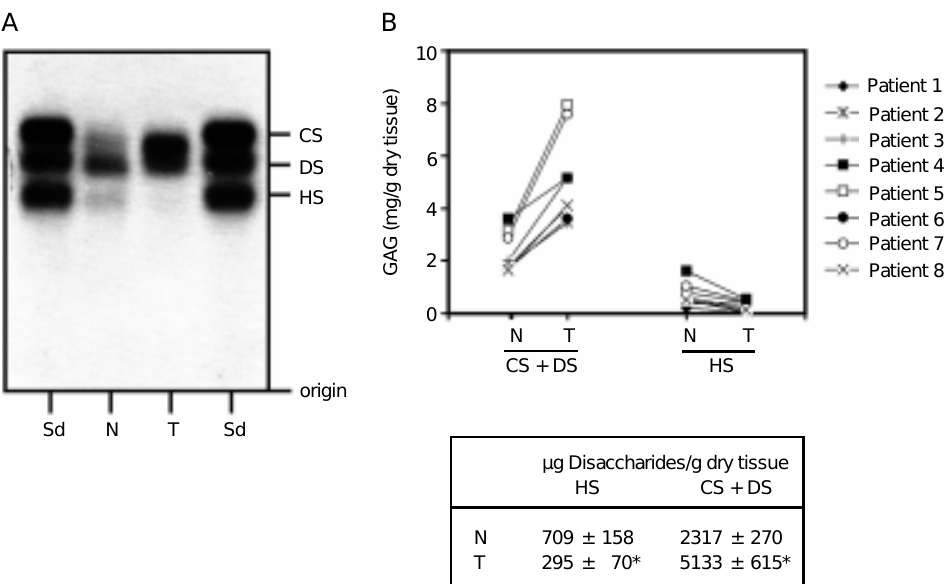
Figure 1. Sulfated glycosami- noglycans (GAGs) from normal human myometrium (N) and leio- myoma (T). A , Agarose gel elec- trophoresis of GAGs extracted from leiomyoma and normal ad- jacent myometrium from patient 1: about 5 µl of the GAGs extracted as described in the text was submitted to agarose gel electrophoresis in 0.05